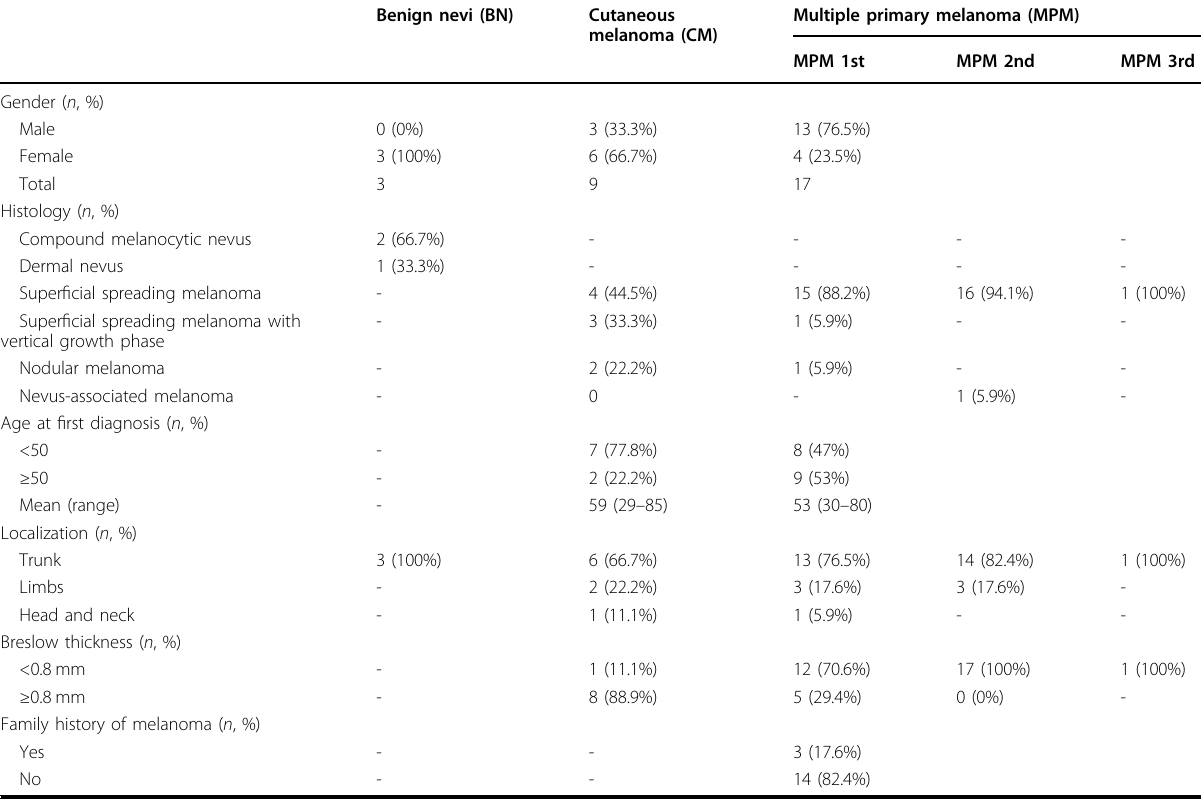
Table 1 Patient